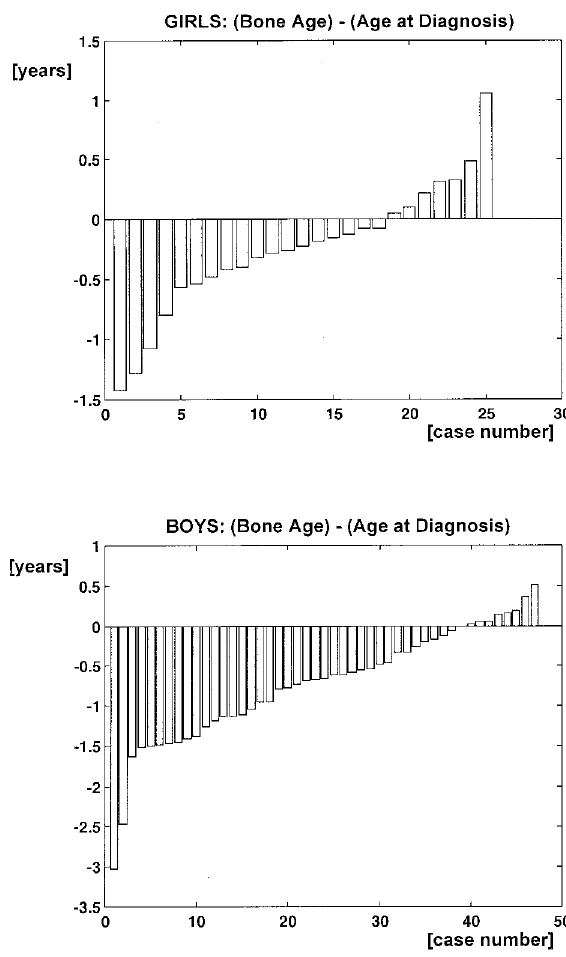
Fig. 1. Difference in bone age and chronological age at diagnosis in 72 children with an osteosarcoma in the area of the knee. A negative value indicates that the bone age was less than the chronological